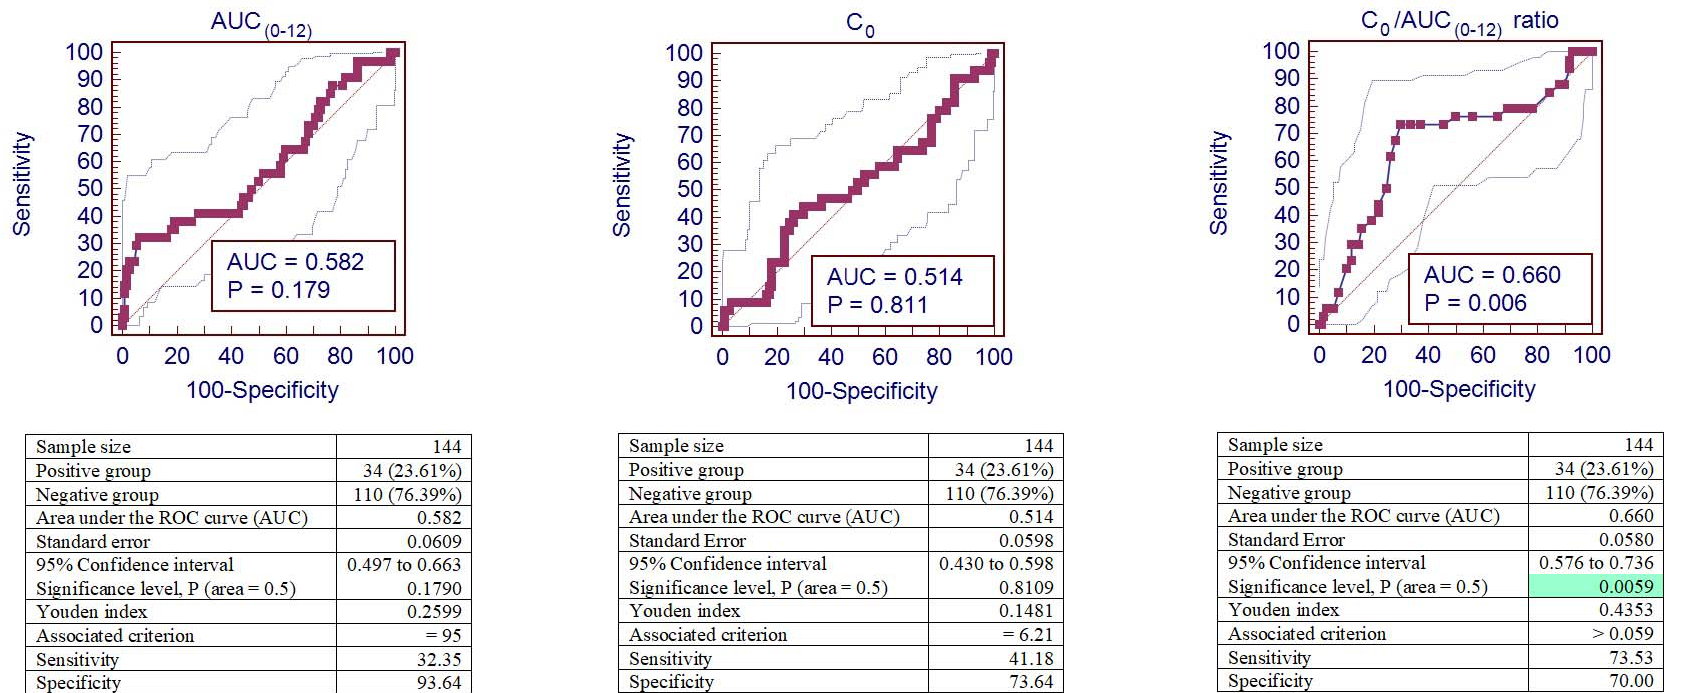
Figure 4. ROC curves of AUC (0–12) , C 0 , and the C 0 / AUC (0–12) ratio for tacrolimus-induced IFTA. Analysis of sensitivity and specificity for IFTA represented by the ROC curves (area under the receiver operator curve—AUROC) in patients after kidney transplantation. The background green color remarks the significant area. IFTA—interstitial fibrosis and tubular atrophy.